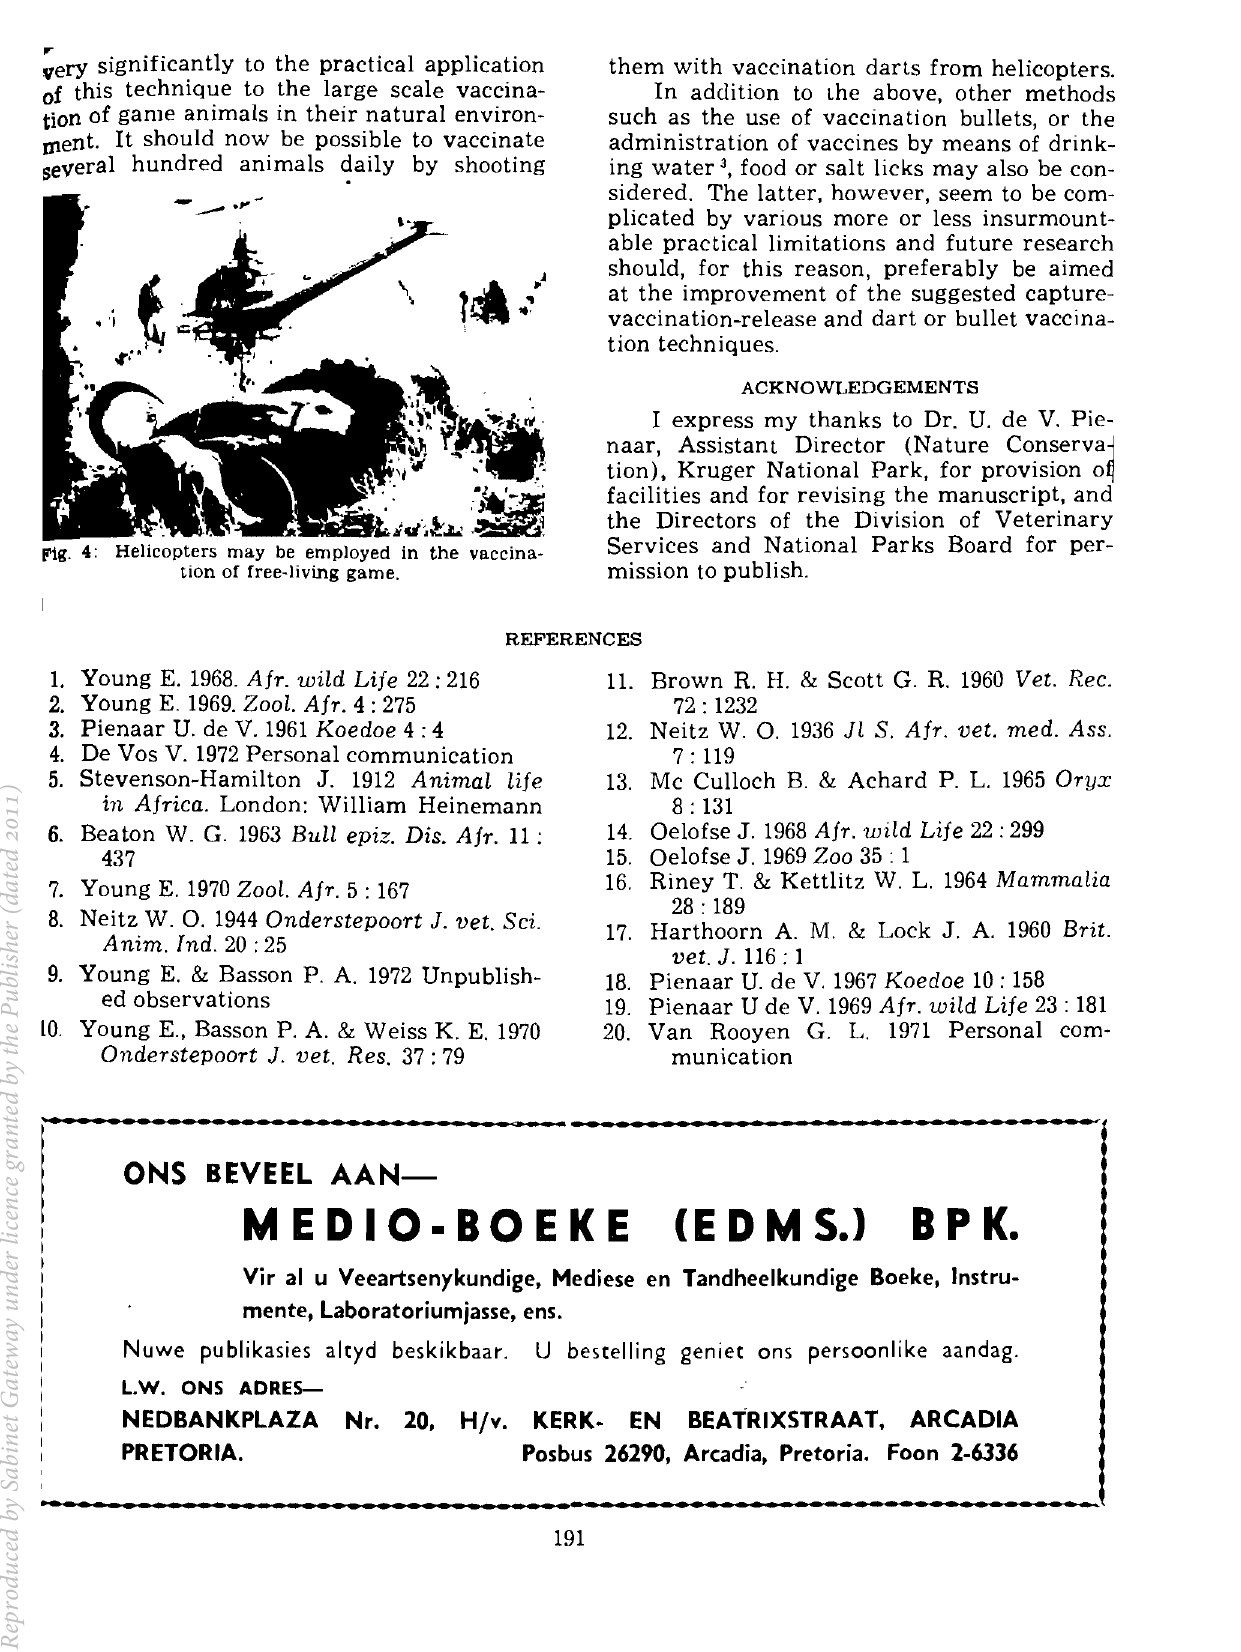
them with vaccination darts from